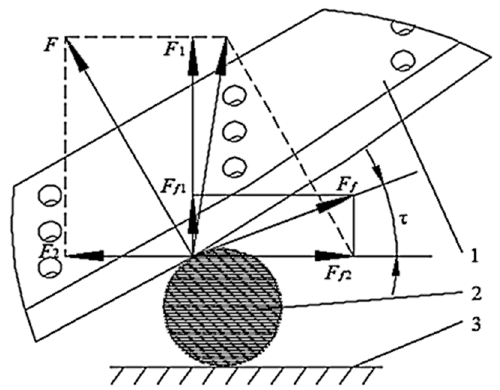
Figure 2. Force analysis and calculation diagram of blade of the chopper: 1. blade of the chopper; 2. ramie stalk; and 3. fixed knife.